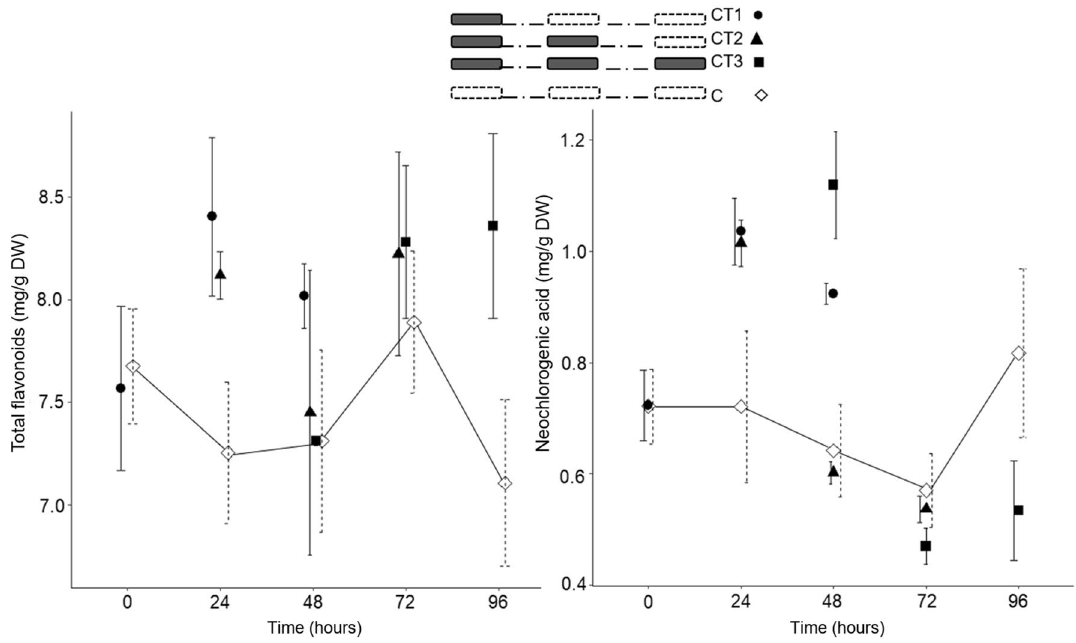
Figure 5. The content of total flavonoids and neochlorogenic acid in leaves of ‘Grace Star’ sampled at time 0, time 24, time 48, time 72 and time 96 in Experiment II. Vertical bars represent ± SE of the mean (n = 3; n = 3, 6 or 9 for controls). For other bar details, see Fig.